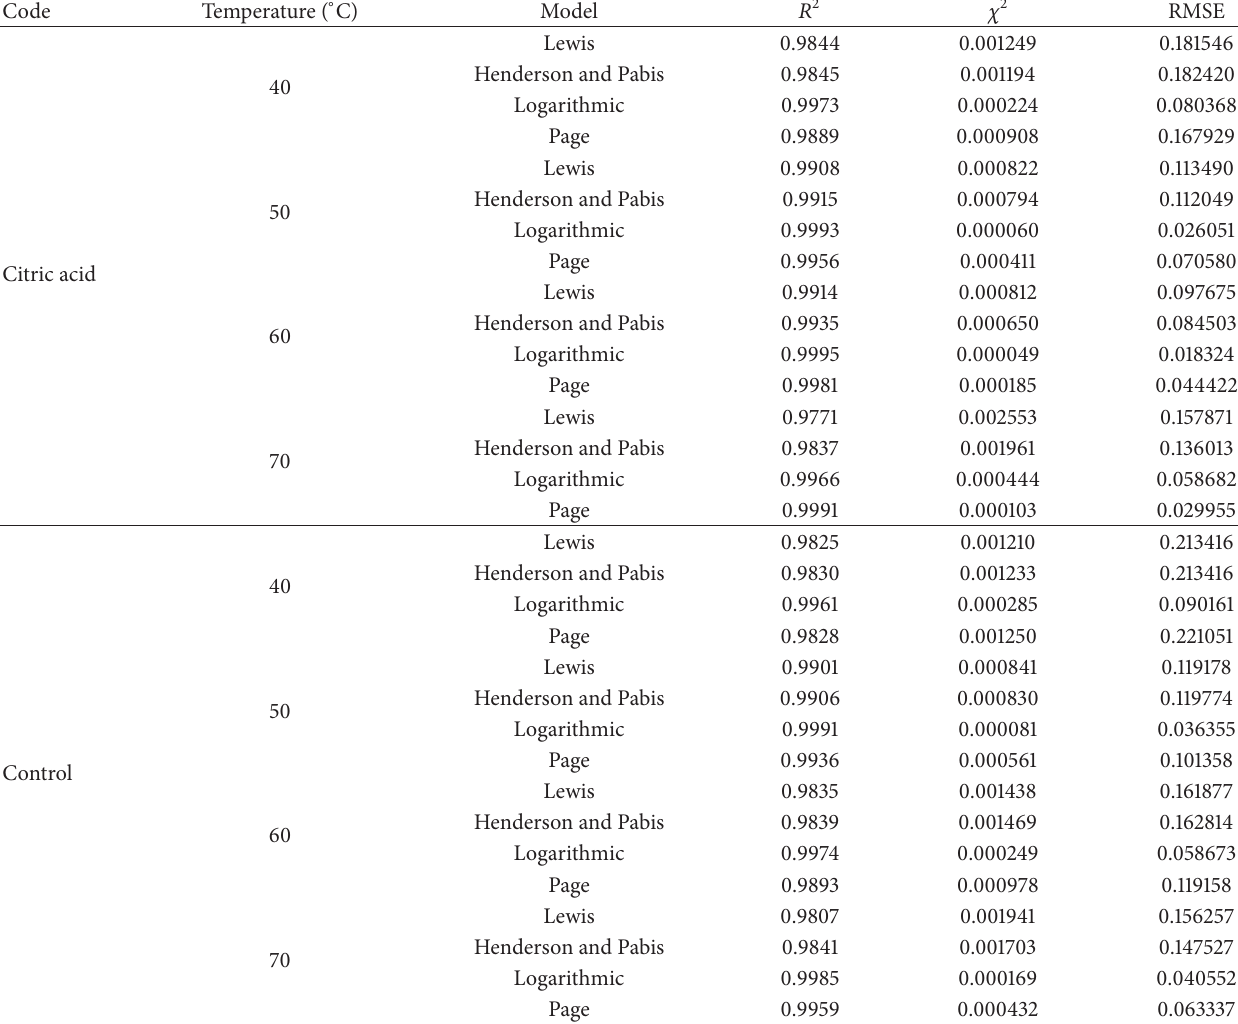
Table 2: Curve fitting criteria for the various mathematical models and parameters for mushroom slices at different